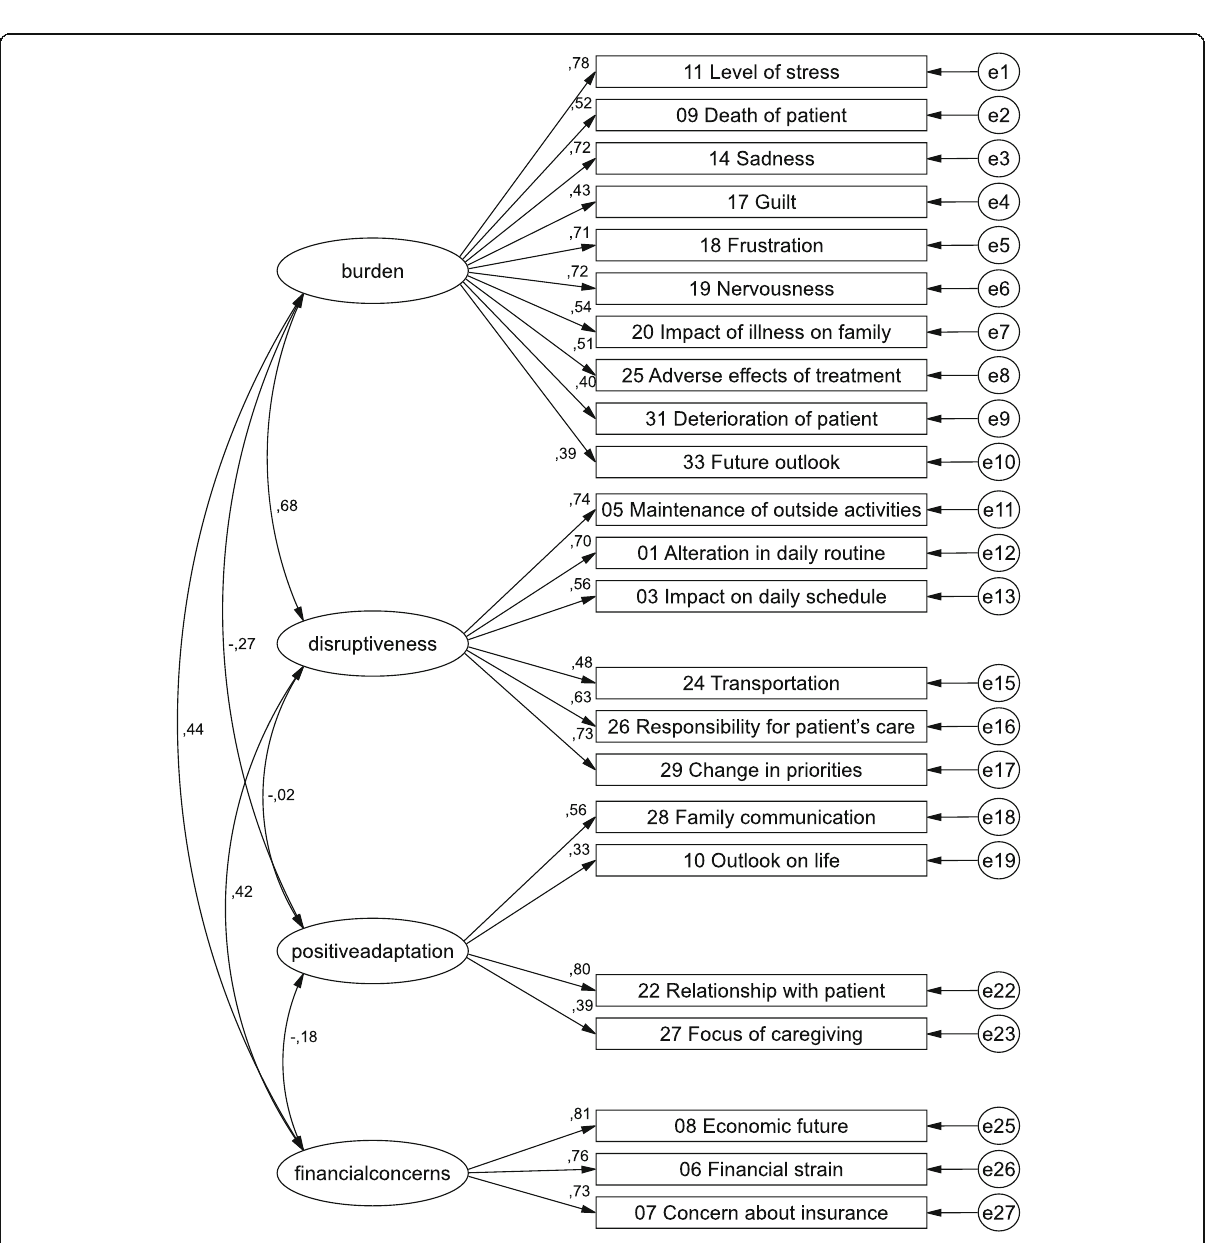
Fig. 2 CFA of the German CQOLC without items 21, 12, 16, and 27